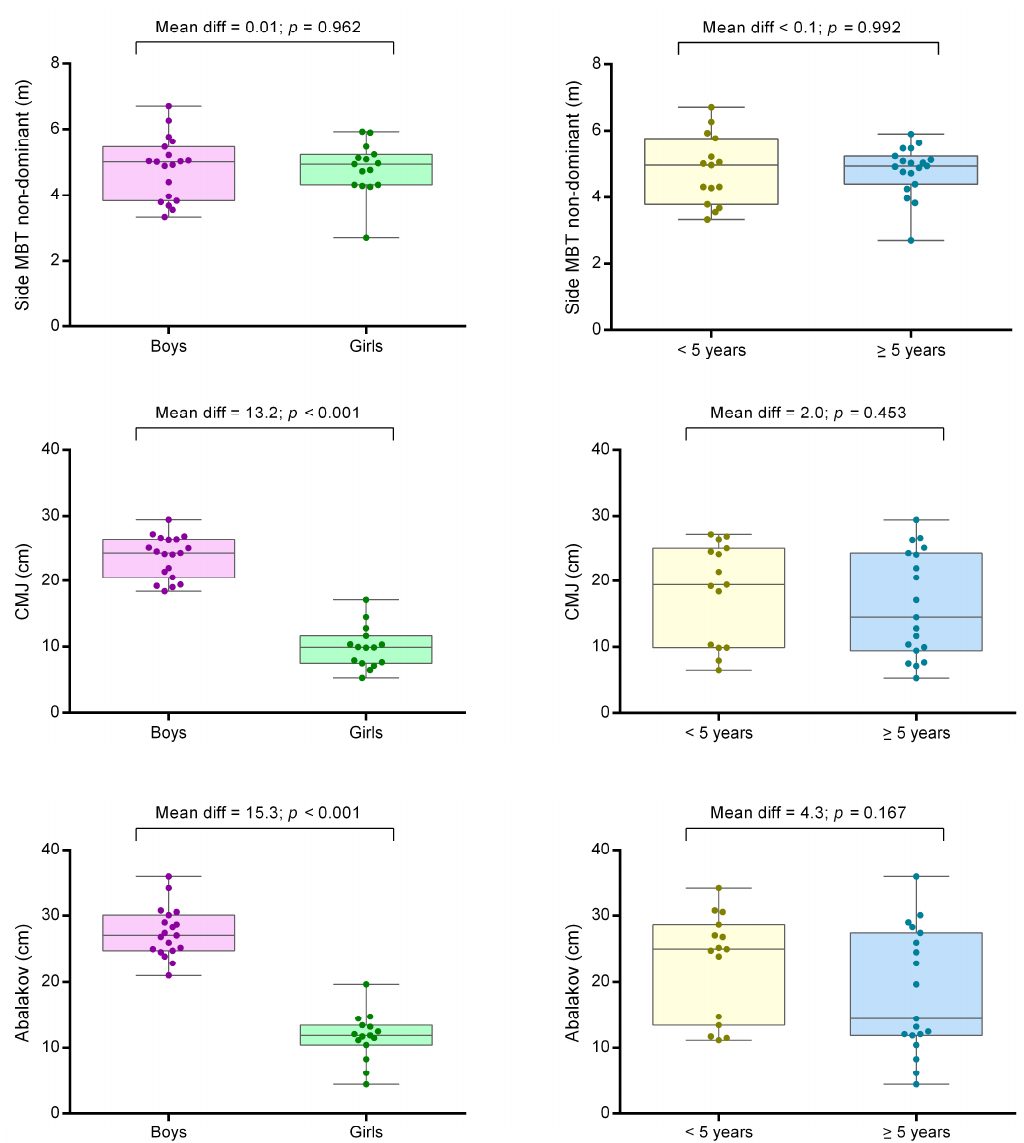
Figure 2. Box and whisker plots of the median (horizontal line), 25th and 75th percentiles (box), range (error bars) and individual scores (markers) for fitness attributes identified as influenced by gender or experience. Left panels are gender group comparisons (boys versus girls). Right panels are the experience groups comparisons considering the median of the sample (lower versus higher than 5 years’ experience). MBT: Medicine ball throw. CMJ: Countermovement jump. Table 2. Influence of gender and experience on body composition and physical fitness values in boys ( n = 19) and girls ( n = 15) padel players aged 13 to 17 years old. Gender Fitness Test